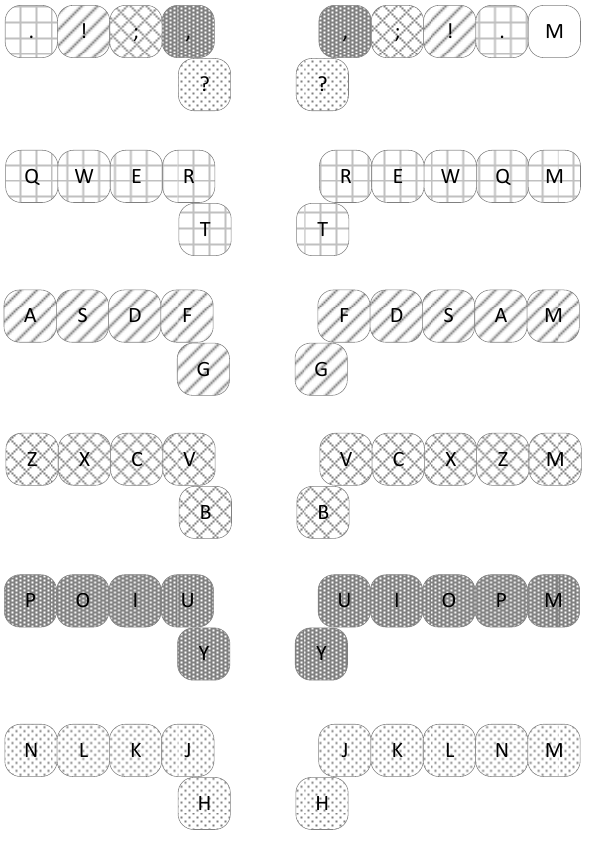
Figure 9. Q-W-ORK+ arrangement.